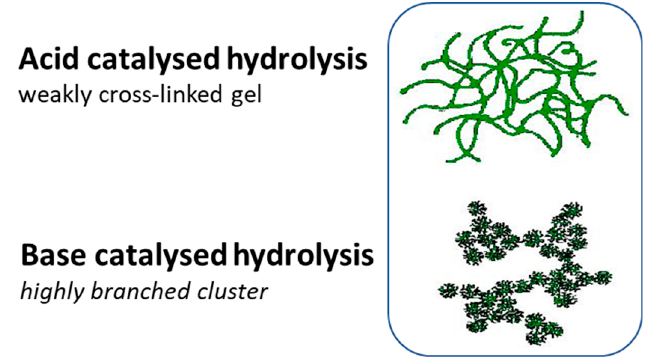
Figure 2. Structure of the gel from acid and basic catalyzed hydrolysis.